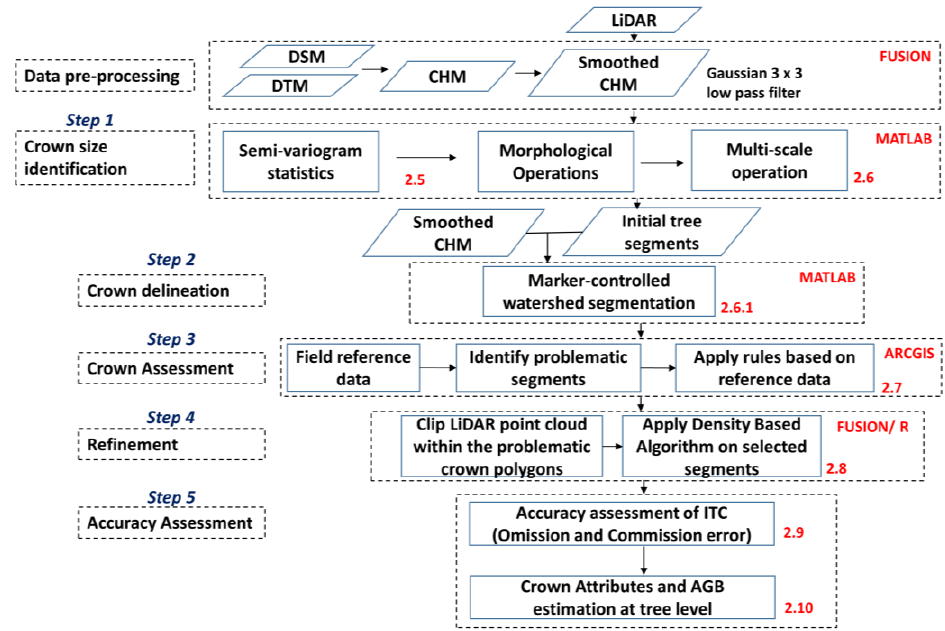
Figure 3. Flowchart of the individual tree crown (ITC) delineation methodology. LiDAR: light detection and ranging.